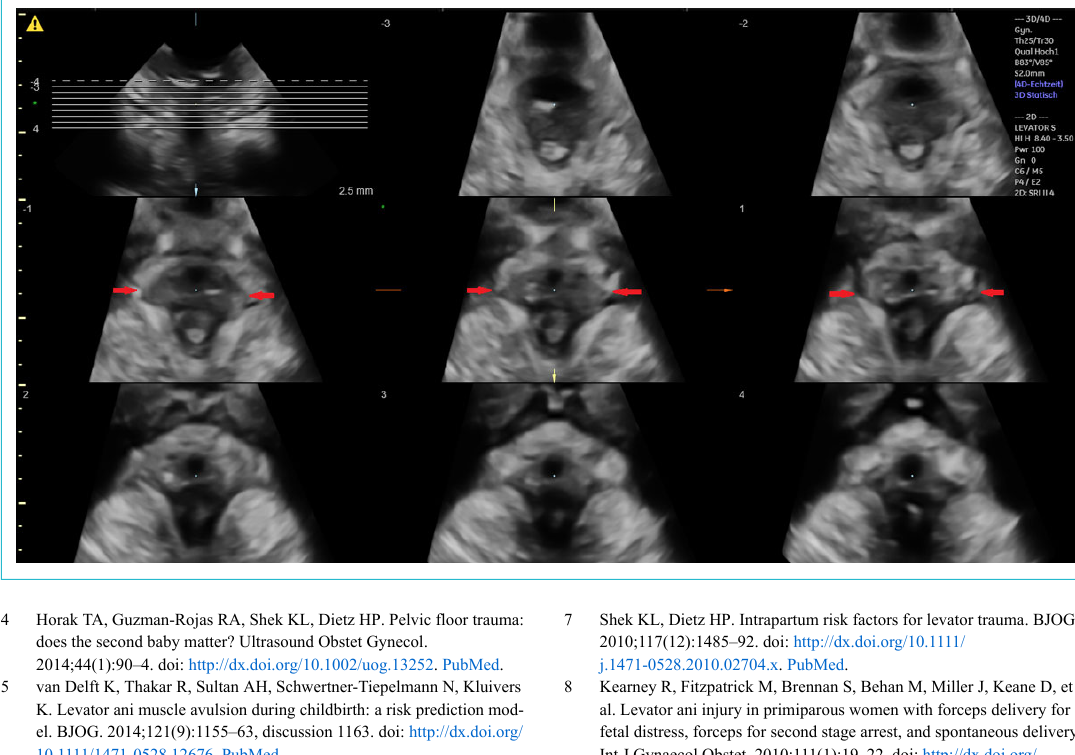
Figure 3b: 3D translabial ultrasound image of a complete bilateral levator ani muscle